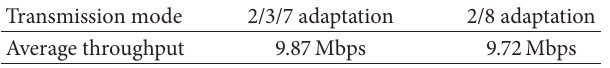
of TM8 owing to the less signalling cost. Although complex radio propagation is provided by the field trail, the data rate of TM3 is approximate to 60 Mbps when SINR is equal to 24 dB. If the SINR is higher than 20 dB, the peak rate of TM2 and TM7 is achieved. It is noted that in each selected location, the test vehicle will not move while the test UE downloads the files. Hence, the doppler frequency shift is small and the beamforming performance enhancement is more remarkable.